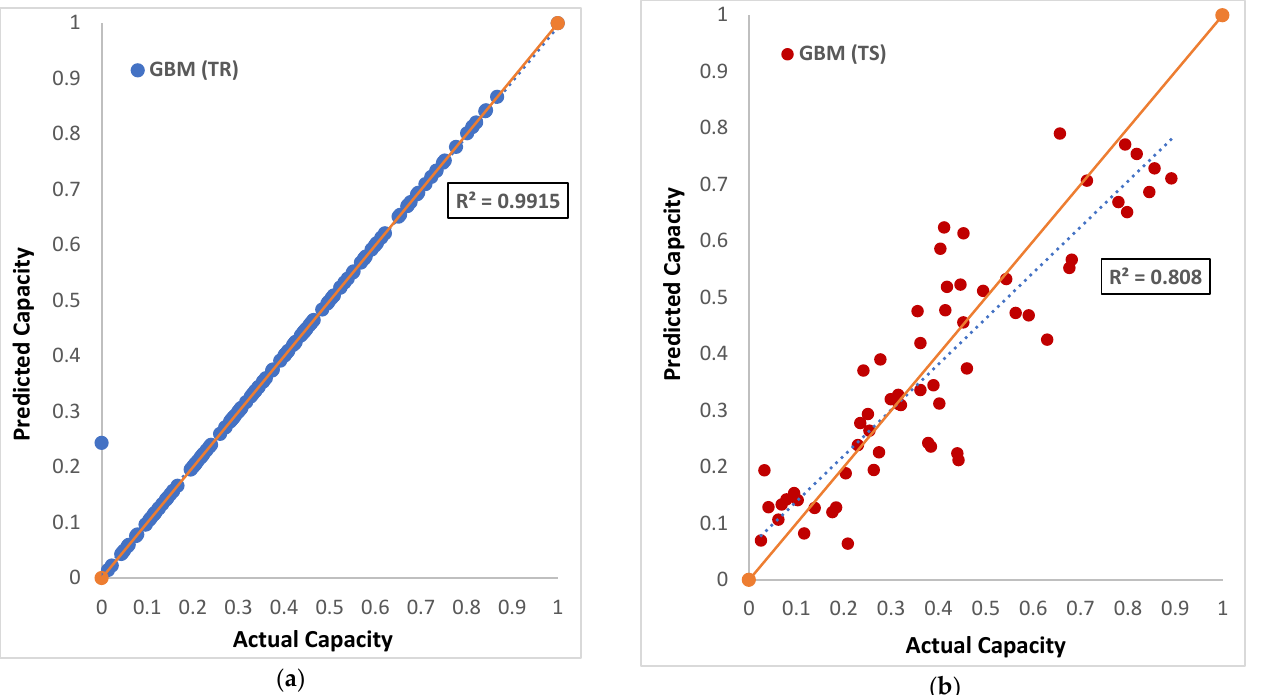
Figure 10. Trend for actual capacity and predicted capacity for GBM model: ( a ) training data; ( b ) testing data.